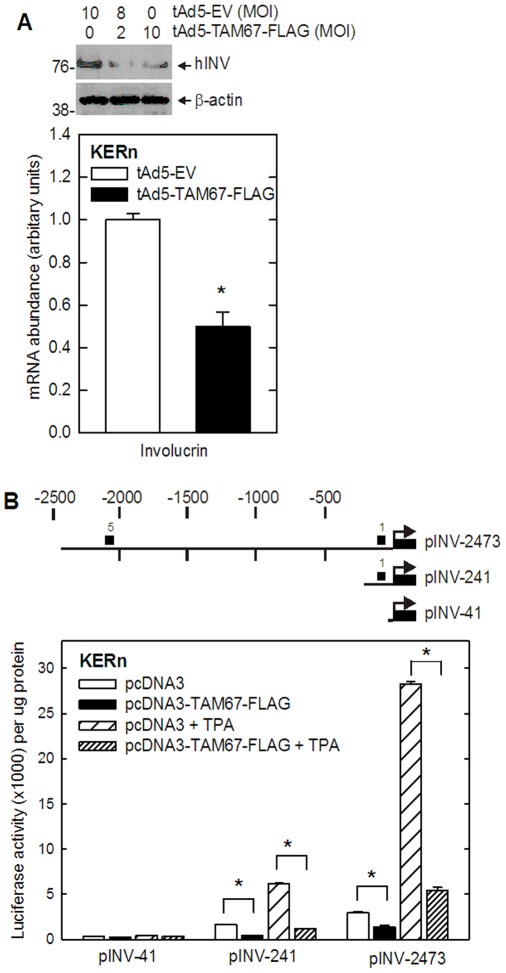
TAM67-FLAG inhibits hINV gene expression.
A TAM67 reduces hINV protein and mRNA level. Keratinocytes were infected with indicated MOI of tAd5-EV or tAd5-TAM67-FLAG and after 48 h extracts were prepared to detect hINV protein by immunoblot and mRNA by quantitative PCR. The values are mean ± SD and the asterisks indicate a significant reduction using student’s t-test, n  = 3 (p<0.001). B TAM67 suppresses AP1 factor-dependent promoter activity. Keratinocytes were transfected with the indicated hINV reporter constructs in the presence of empty pcDNA3 vector or pcDNA3-TAM67-FLAG and treated 24 h with or without 50 ng/ml TPA prior to preparation of extracts and assay of luciferase activity. The values are mean ± SEM and the asterisks indicate a significant reduction using student’s t-test, n = 3 (p<0.001).